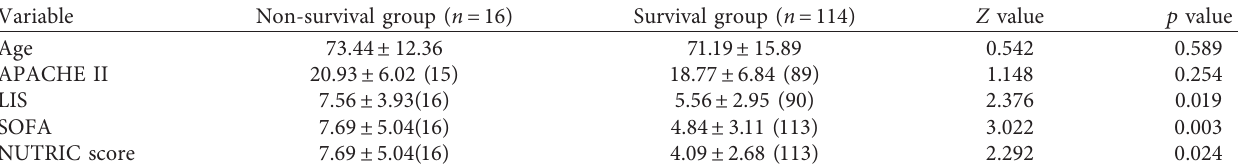
Table 5: Age, APACHE II, LIPS, SOFA and NUTRIC scores between survival and nonsurvival patients.